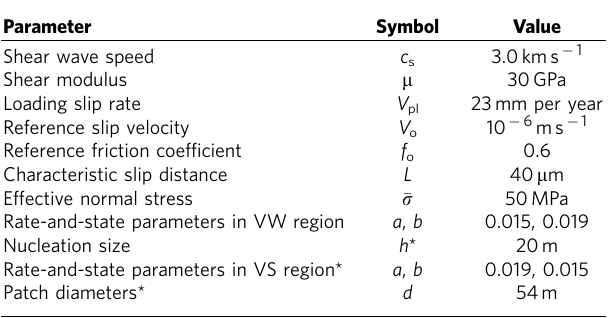
Table 1 | Parameters of our simulations. Parameter